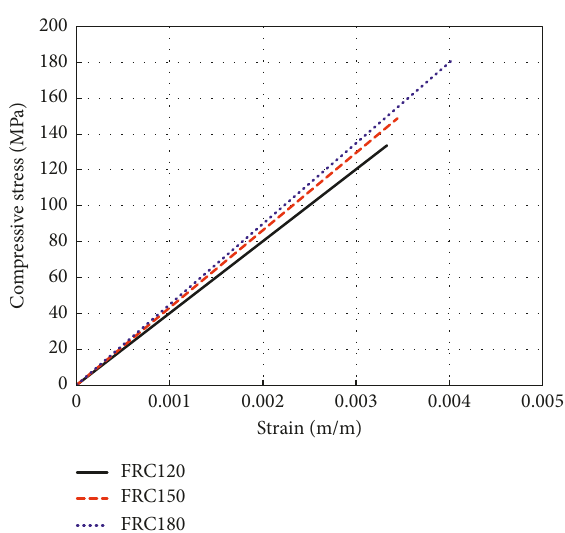
Figure 4: Modeling of the compressive behavior of